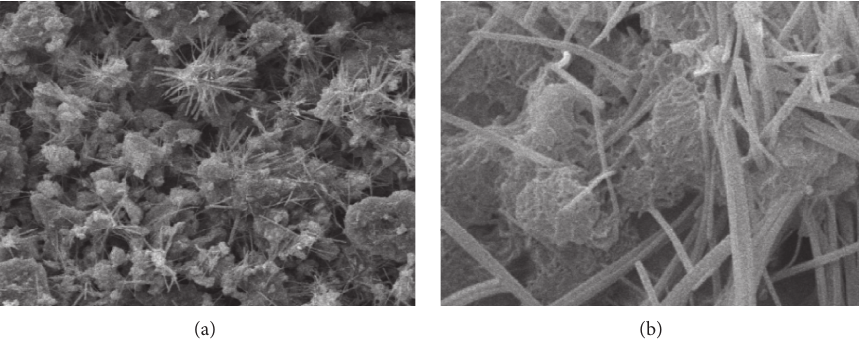
Figure 10: SEM diagram of 7 days of specimen maintenance: (a) × 500; (b) × 5000.